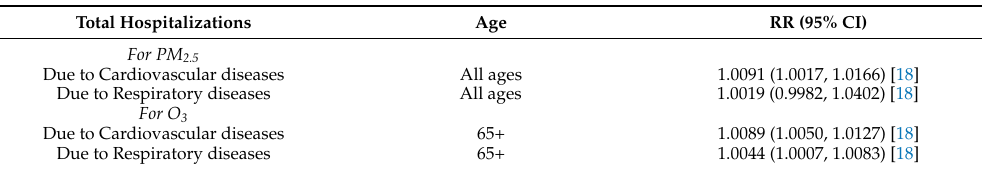
Table 2. Relative risks (RR) and 95% confidence intervals (CIs) for total hospitalizations for a 10 µ g/m 3 change in PM 2.5 and O 3